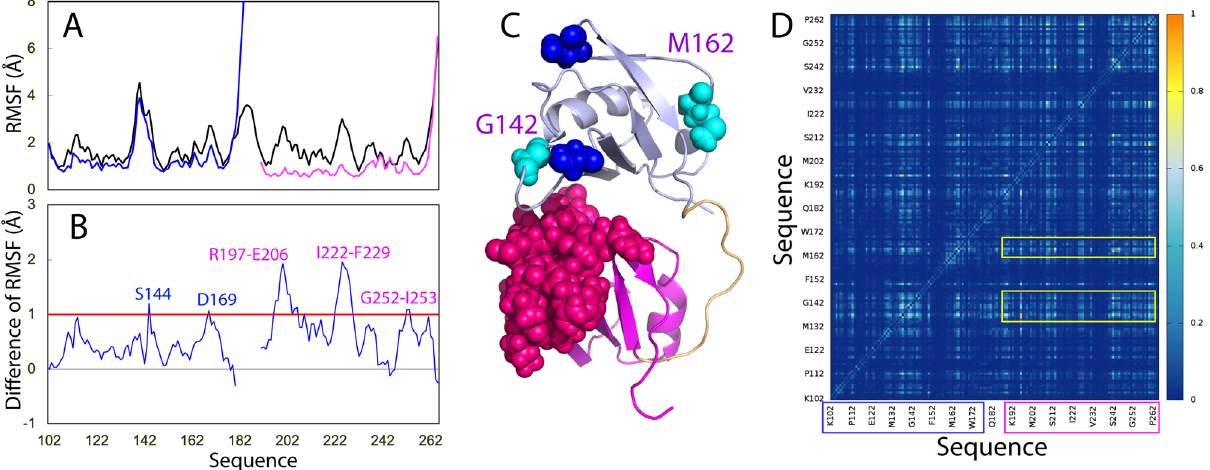
Figure 7. Residue-specific dynamic behaviors of the TDP-43 RRM domains. ( A ) Averaged root-mean-square fluctuations (RMSF) of the Cα atoms computed over three independent MD simulations for the tethered RRM1–RRM2 (black), as well as isolated RRM1 (blue) and RRM2 (pink). ( B ) The difference of the average RMSF between the tethered RRM1–RRM2, and isolated RRM1/RRM2. The residues are labeled for those with significant difference of RMSF (> 1.0; average + one STD). ( C ) Structure of the TDP-43 RRM1–RRM2 with the residues displayed in spheres which show significant difference of RMSF between the tethered and isolated forms. The image was prepared by PyMol2.4 (https ://pymol .org). ( D ) Mutual information matrix calculated from three parallel MD simulation data of the tethered TDP-43 RRM1–RRM2 by MutInf, with residues having significant inter-domain correlation motions highlighted by yellow boxes. The RRM1 sequence is indicated by blue box and RRM2 sequence in pink